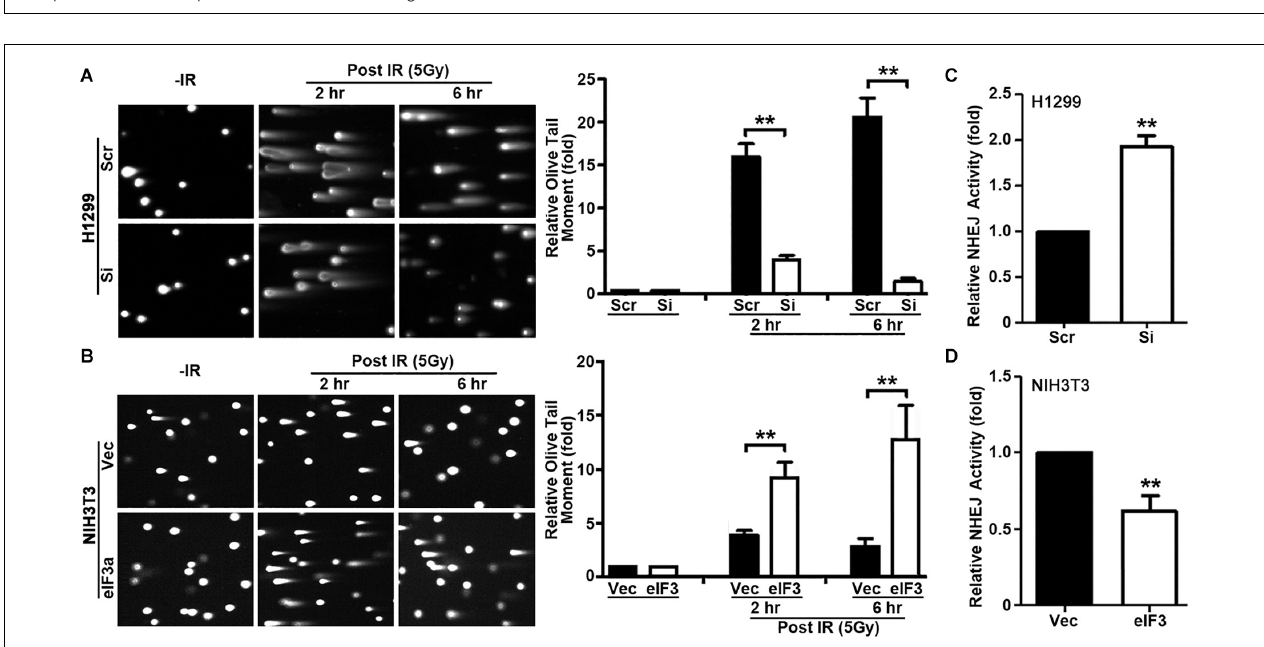
FIGURE 2 | Effect of eukaryotic initiation factor (eIF)3a on ionizing radiation (IR)-induced gamma-H2A histone family member X ( γ -H2AX). Western blot (A) and immunofluorescence staining (B) analyses of γ -H2AX in H1299 cells with transient eIF3a knockdown and in NIH3T3 cells with stable eIF3a overexpression compared with their respective control cells following IR treatments.